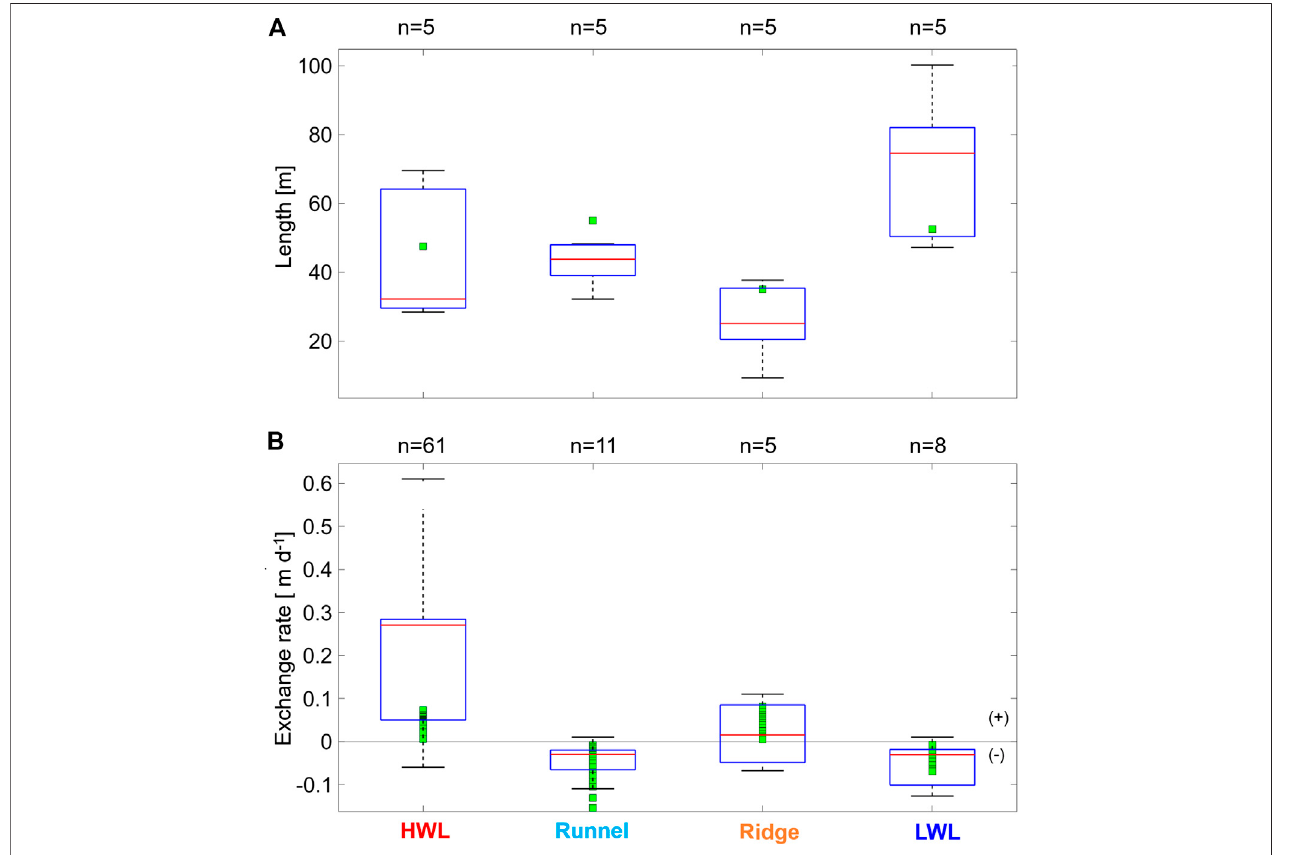
FIGURE 6 | (A) Areal variation of respective in- and ex fi ltration zone (HWL, Runnel, Ridge, LWL) in the intertidal zone normalized to 1 m shoreline for sampling campaigns March (1) 2017, March (2) 2017, May 2017, August 2017, and February 2018 based on Supplementary Figure S8 . Green squares indicate model results. (B) Variation of measured exchange rates within respective in- and ex fi ltration zone (HWL, Runnel, Ridge, LWL) in the intertidal zone. Positive rates indicate in fi ltration, negative rates ex fi ltration, respectively. Green squares indicate model results. Black dots are values that are more than 1.5 times the interquartile range away from the top or bottom of the box. Red line indicates median of boxplot. Number of statistics ( n ) is given above.